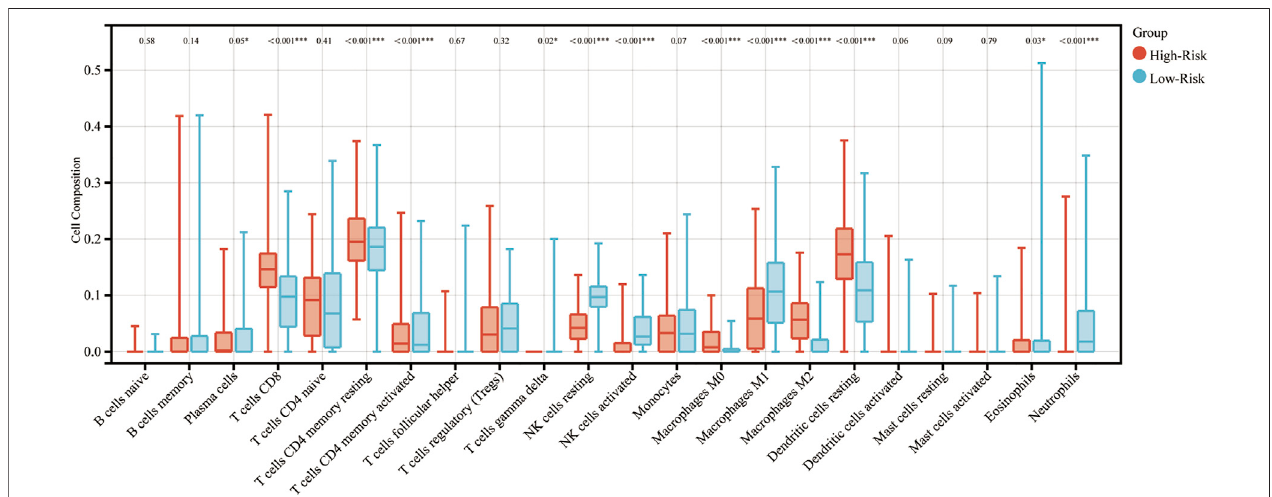
FIGURE 4 | Association between immune cell in fi ltration and the immune-related signature in glioma. The blue columns represent the low-risk groups. The red columns represent the high-risk groups.